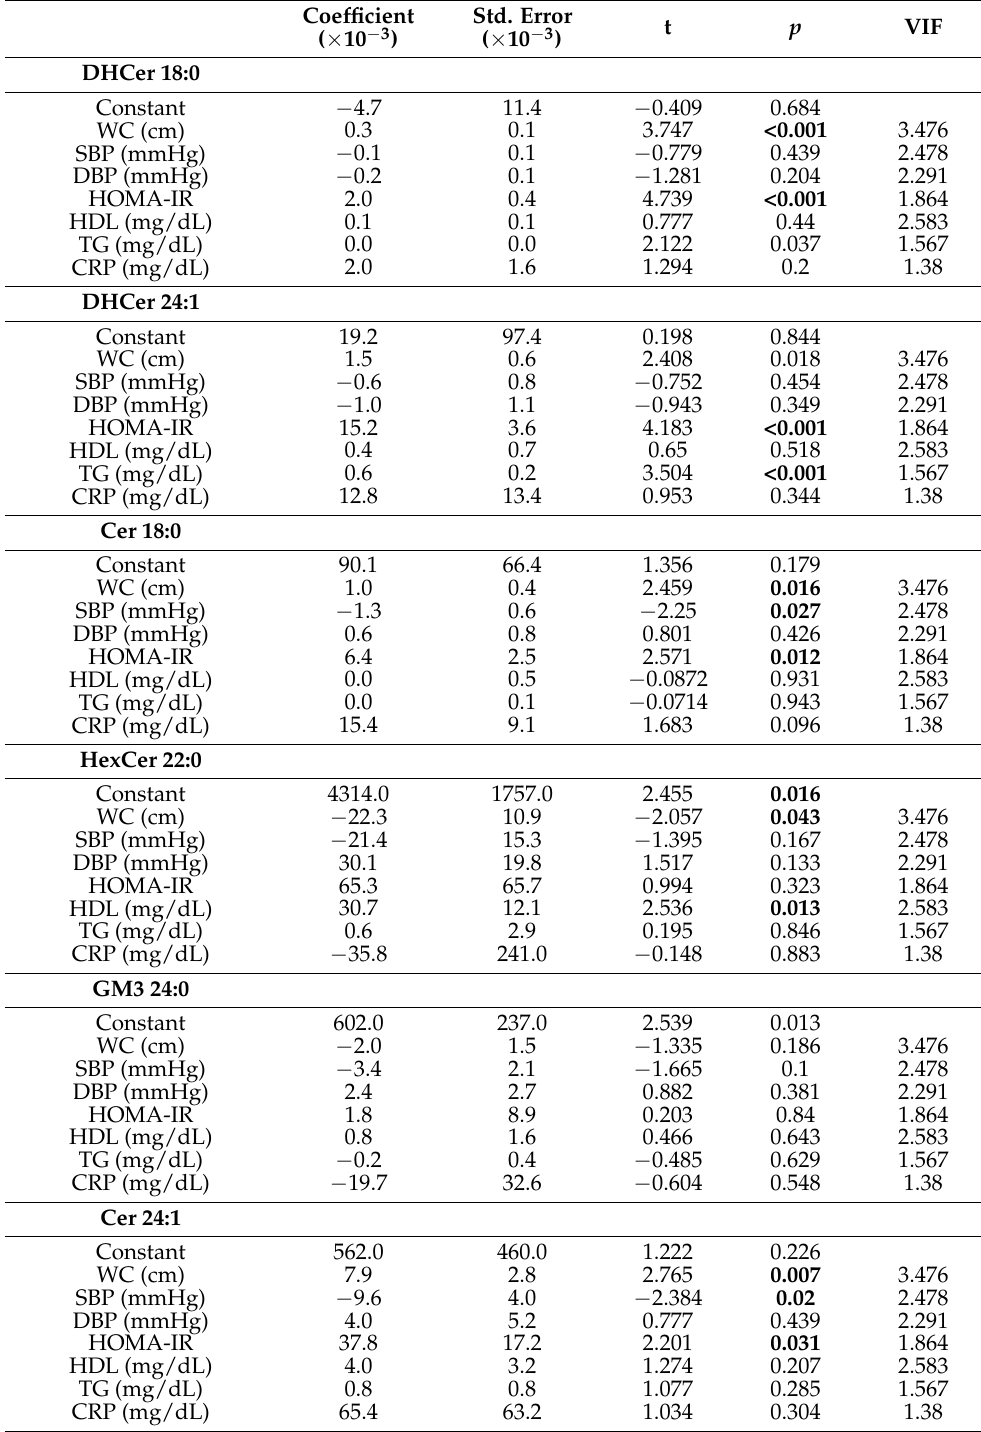
Table 3. Multiple linear regression of each sphingolipid (dependent variable) with surrogates of IDF diagnostic criteria for metabolic syndrome (independent variables), i.e., WC, SBP/DBP, HOMA-IR, HDL, and TG, including